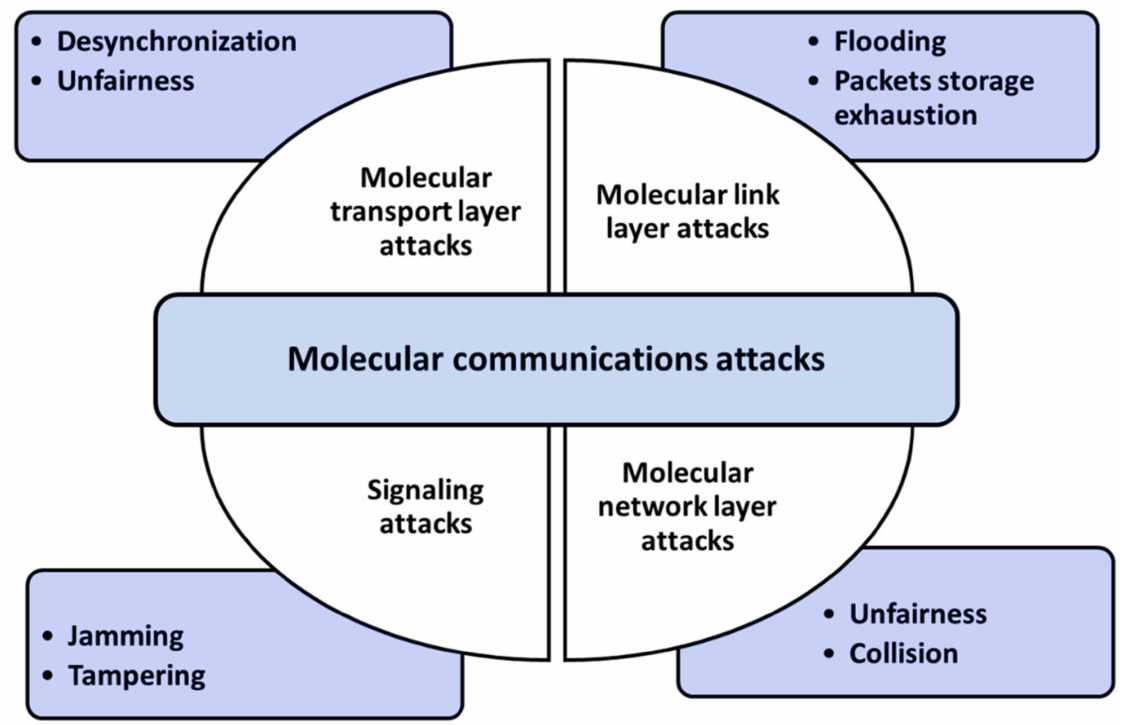
Figure 5. The 6G molecular communication attacks and